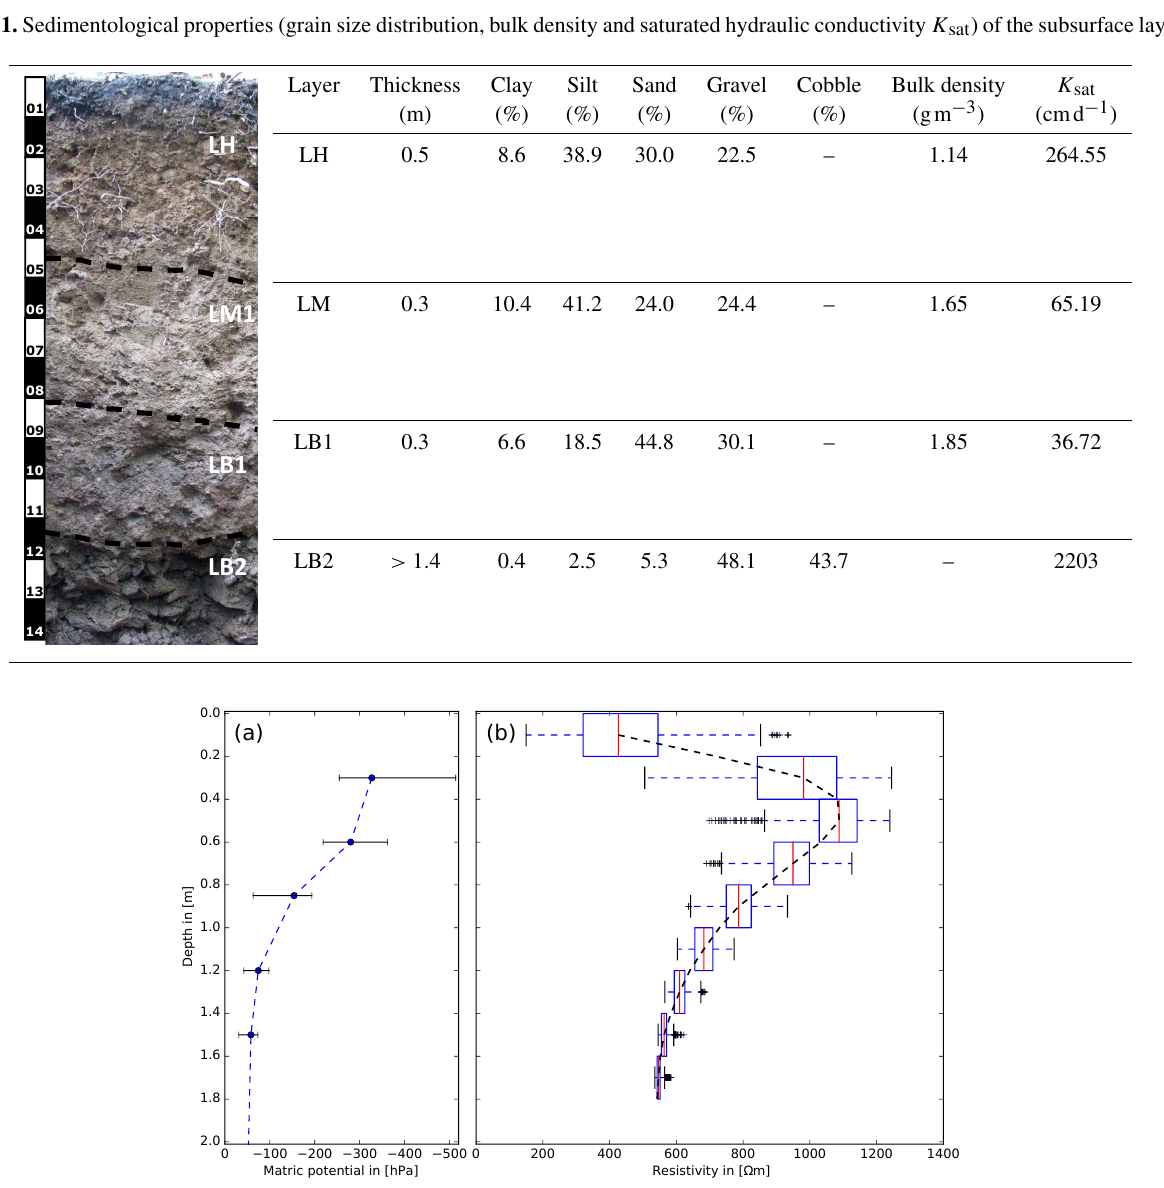
Figure 3. Average initial matric potential (a) with range of variation and statistical distribution of resistivity (b) as a function of depth for eight 0.2m thick depth